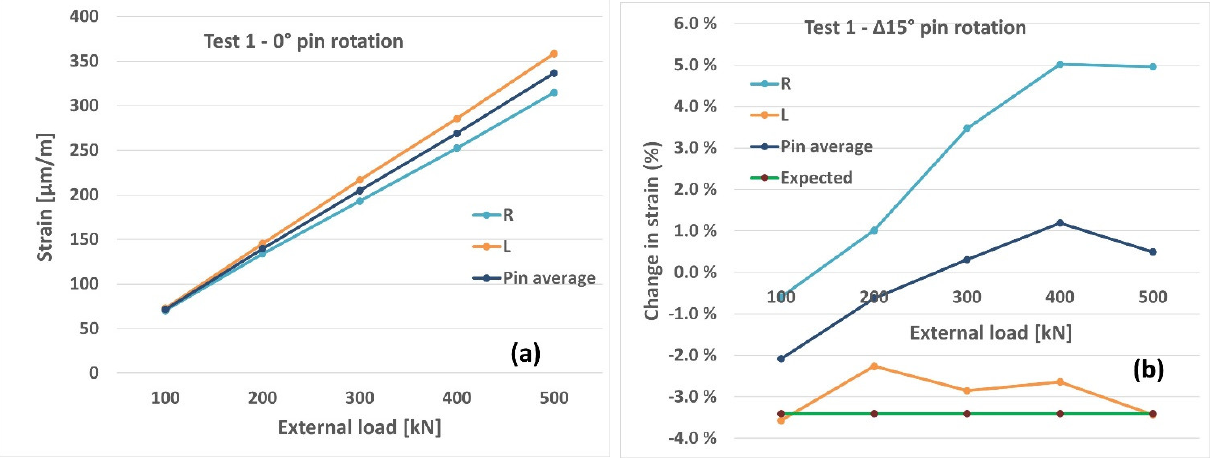
Figure 9. Test 1, ( a ) strains at 0° position, ( b ) percentage change of strains from 0° to 15° position.